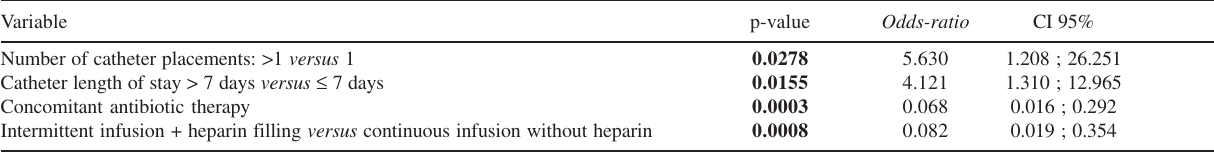
Table 3 - Analysis of risk factors for catheter-related infections using multivariate logistic regression, adjusted for age. Variable Number of catheter placements: >1 versus 1